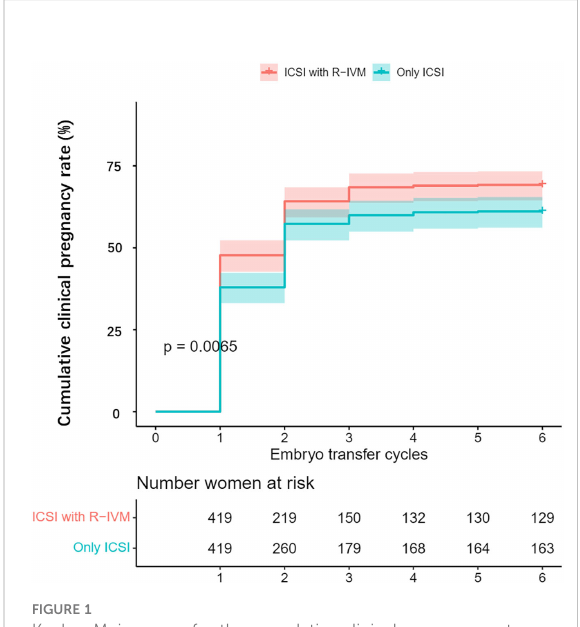
FIGURE 2 Kaplan-Meier curve for the cumulative live birth rate after propensity score